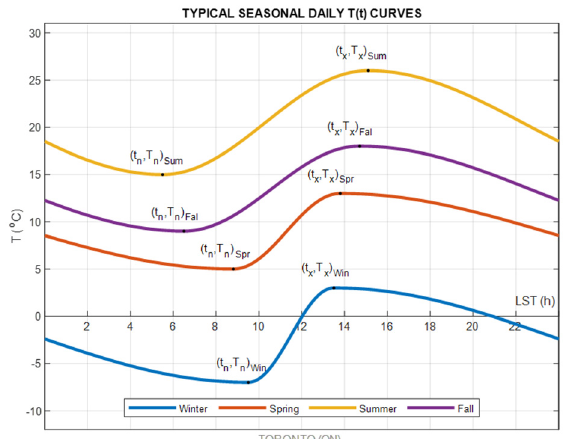
Figure 1. Averaged daily variability of a temperature-time function during four seasons on the example of Toronto, Ontario, Canada (43°40 ′ 38 ″ N, 79°37 ′ 50 ″ W). Diurnal Extrema Timing minimum is denoted as t n , while Diurnal Extrema Timing maximum is denoted as t x . Abbreviations: Win represents Winter, Spr represents Spring, Sum represents Summer, and Fal represents Fall.